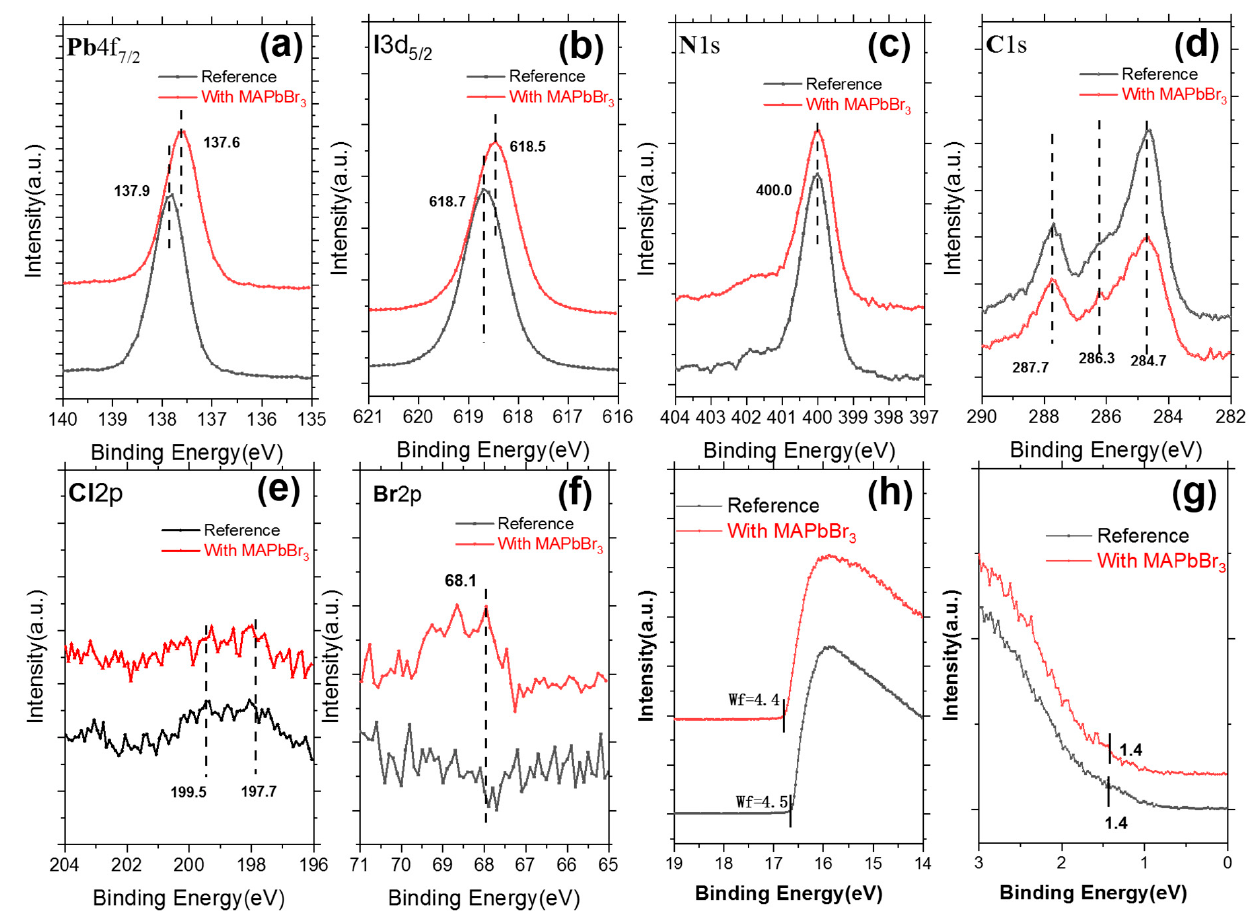
Figure 4. ( a ) Pb 4 f 7/2 , ( b ) I 3 d 5/2 , ( c ) N 1 s , ( d ) C 1 s , ( e ) Cl 2 p , ( f ) Br 2 p core-level spectra, and ( h ) SECO and ( g ) VB spectra for perovskite films with and without MAPbBr 3 . Table 1. Proportions of elements on the film surface of the reference and target samples, where the proportions of each element are relative to the content of Pb